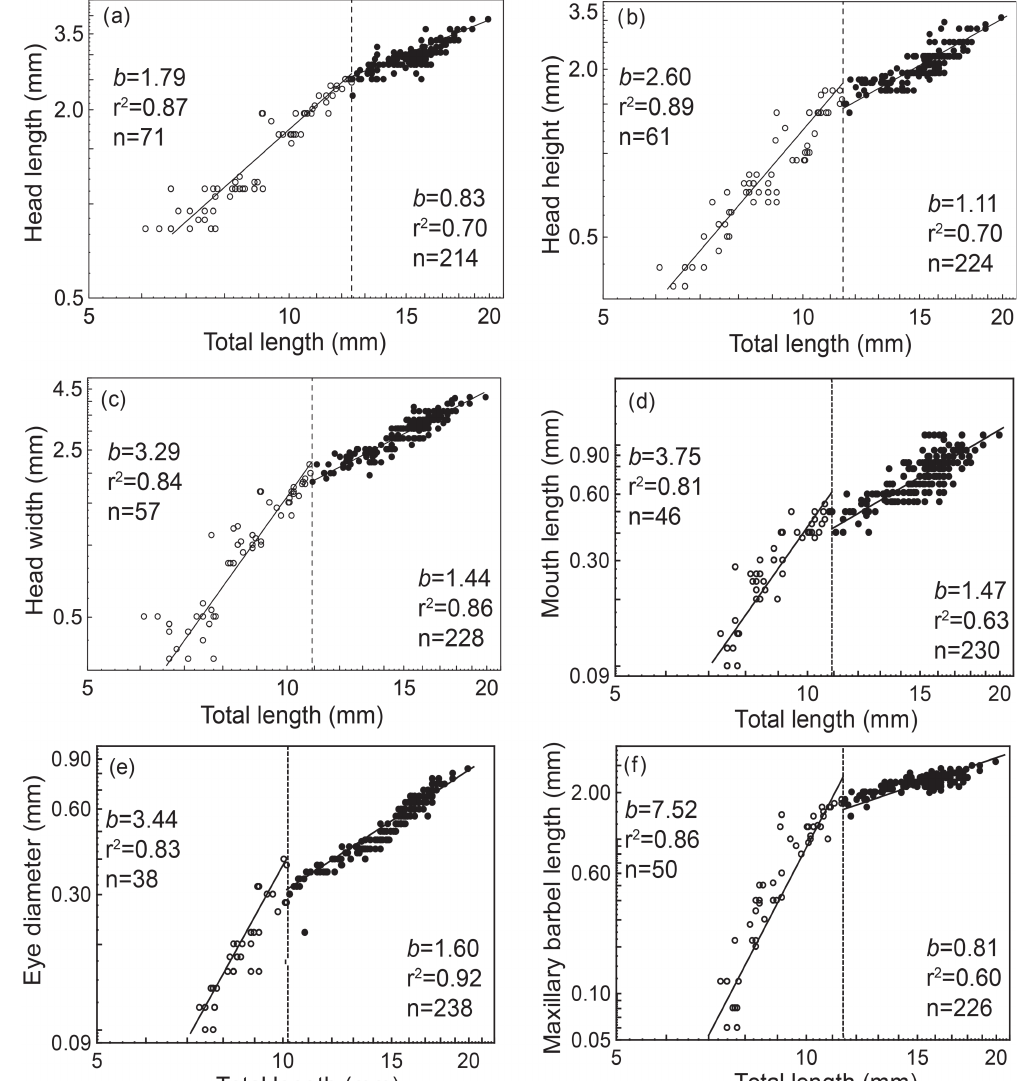
Fig. 3. Allometric growth of measurements on the head of Lophiosilurus alexandri during early development (0-29 days after hatching). The dotted line on total length represents the inflexion point of growth, b = allometric growth coefficient, r² = coefficient of determination, and n= number of individuals. (a) head length, (b) head height, (c) head width, (d) mouth length, (e) eye diameter, (f) maxillary barbel